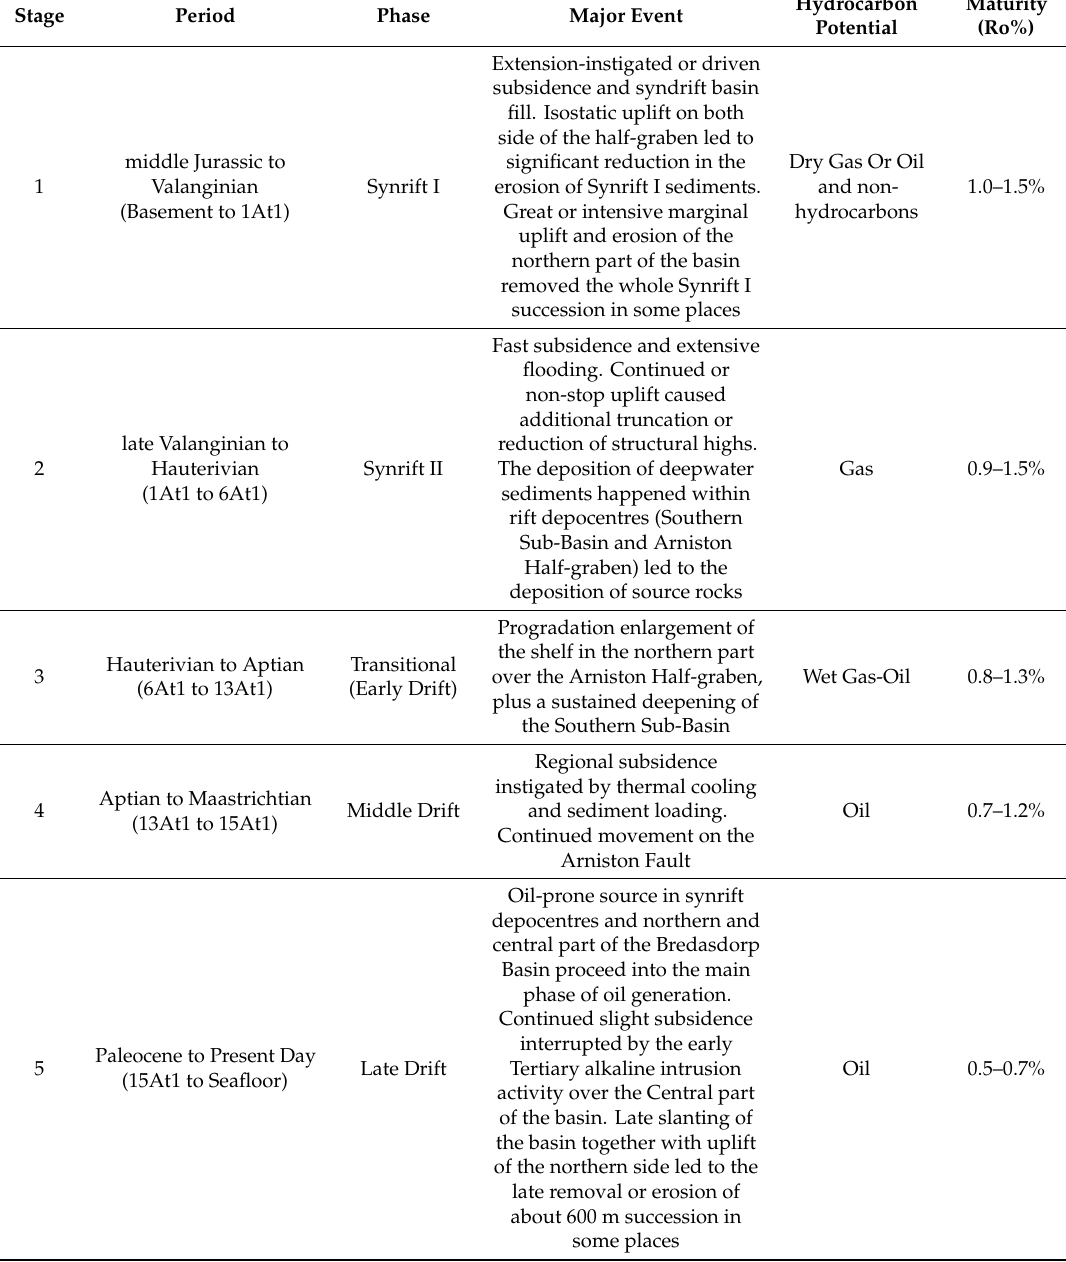
Table 1. Summary of the structural development of the Bredasdorp Basin hydrocarbon potential and maturity of source rocks (after